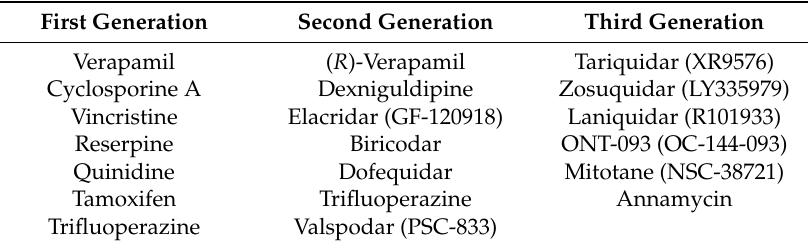
Table 1. Examples of classical P-gp inhibitors by generation.